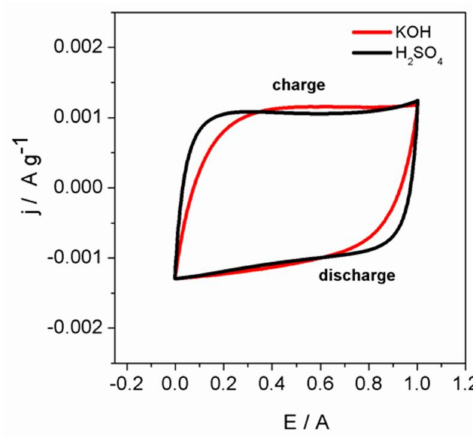
Figure 10. Cyclic voltammetries recorded at 20 mV · s − 1 . The electrolyte used is indicated for each curve in the